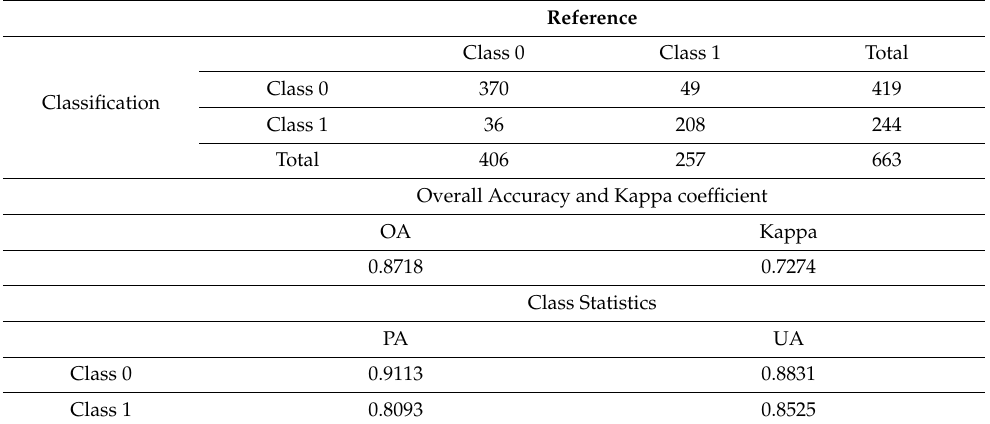
Table A2. S2 classification (“scheme 1”).